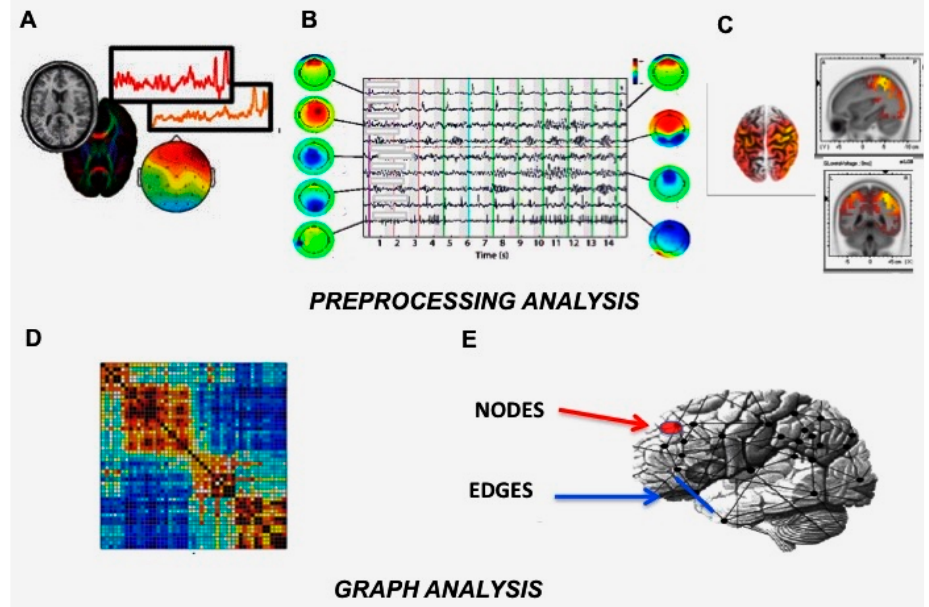
Figure 1. Functional connectivity data analysis: from EEG recordings ( A ), signals are preprocessed with ICA for the artifacts’ rejection ( B ), and the eLORETA algorithm is applied to extract EEG sources’ localization ( C ). Then, the graph analysis is applied with the construction of an adjacency matrix, square arrays of numbers where rows and columns correspond to nodes, and individual entries correspond to all possible connections ( D ). Nodes can correspond to specific regions, superficial signal recording sites, EEG sources, whereas edges can represent values of functional coupling between nodes ( E ).